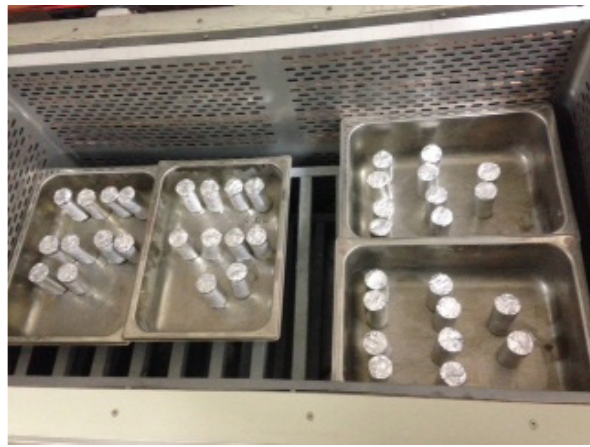
Figure 2: Closed system full automatic freezing–thawing test cabinet.